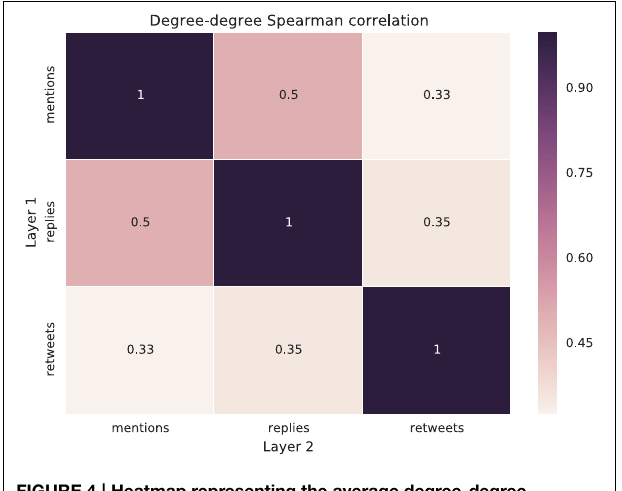
FIGURE 3 | Heatmap representing the edge overlap between pairs of layers, averaged over the different events.